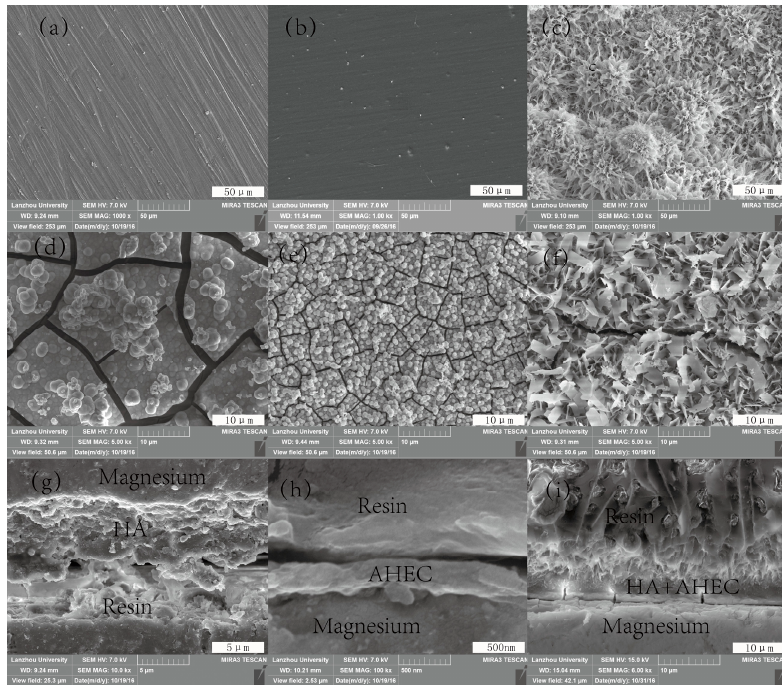
Figure 1. Scanning electron microscopy (SEM) images of AZ31, aminated hydroxyethyl cellulose (AHEC)/AZ31, and hydroxyapatite/aminated hydroxyethyl cellulose (HA/AHEC)/AZ31 specimens: before ( a – c ); and after ( d – f ) immersion in simulated body fluid (SBF) for 7 days; and the cross-sections of: ( g ) HA/AZ31; ( h ) AHEC/AZ31; and ( i ) HA/AHEC/AZ31.